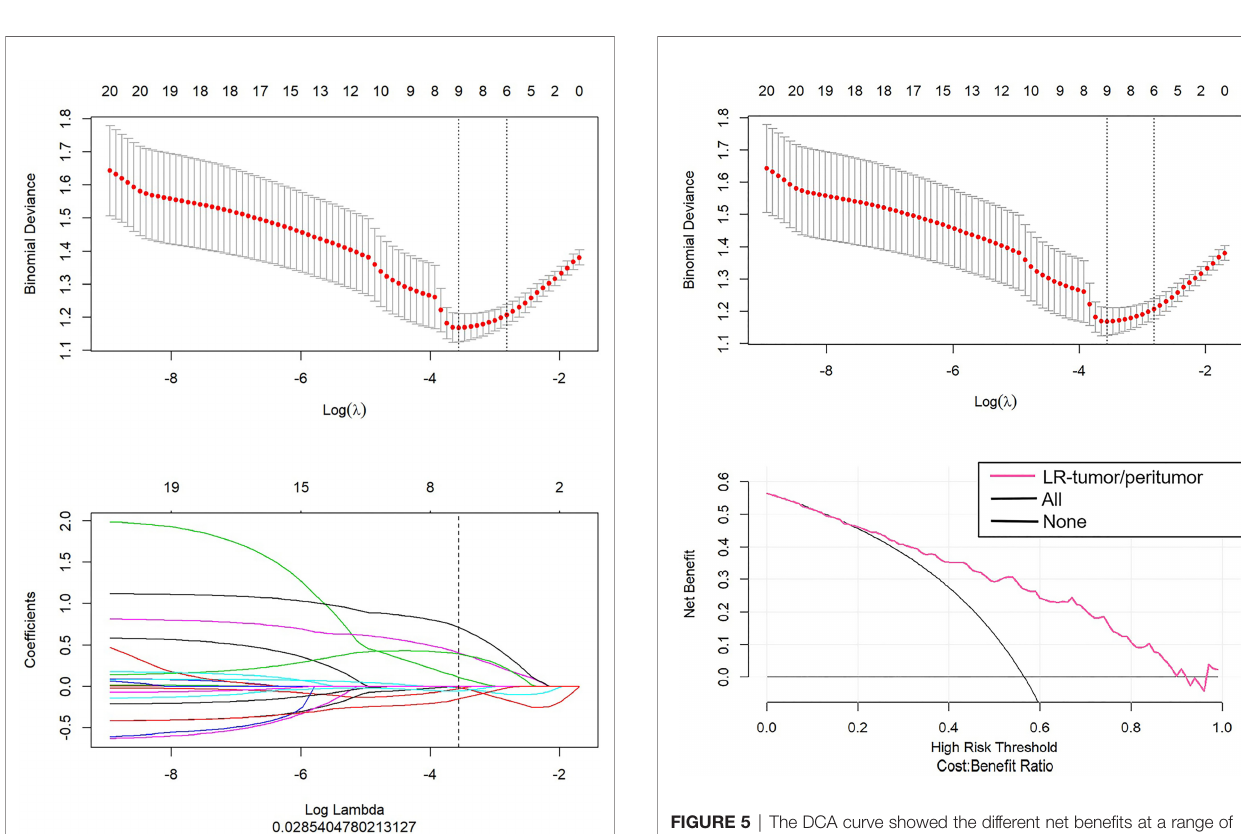
FIGURE 5 | The DCA curve showed the different net bene fi ts at a range of threshold probabilities in